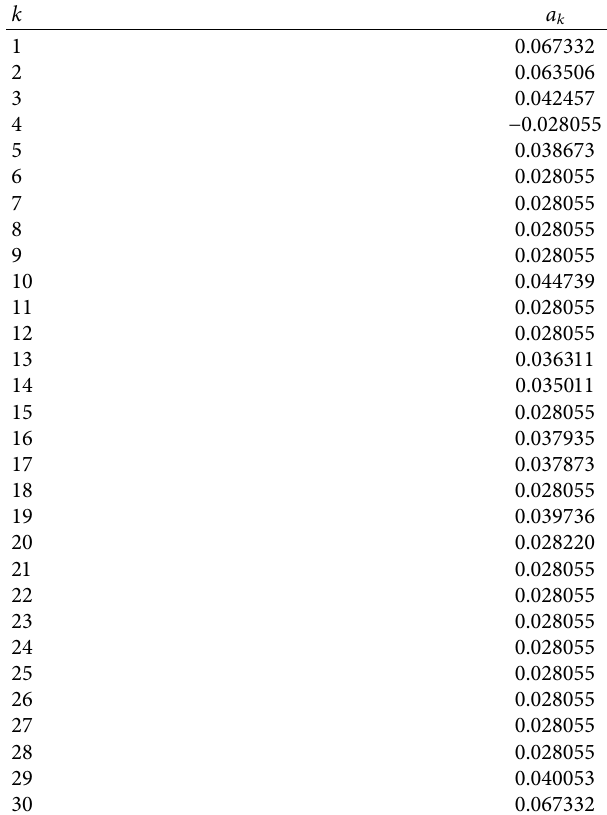
Table 5: Optimum coefcients of proposed array from Table